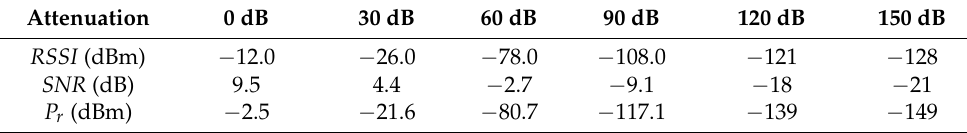
Table 6. Results received at the gateway side at different attenuation